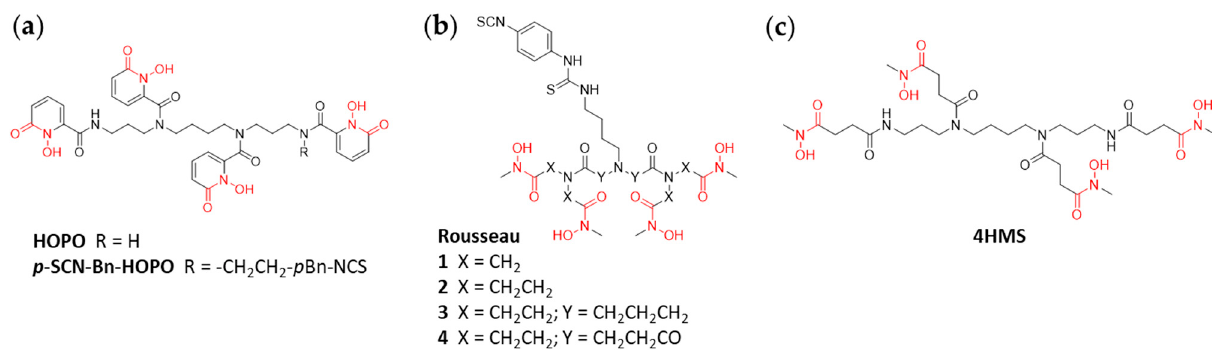
Figure 6. Acyclic hydroxamate chelators. ( a ) 1,2-hydroxypyridone based chelator. ( b ) symmetrical chelators (Rousseau 1 and 2) based on a 2,2 ′ -iminodiacetamide backbone; Rousseau 3 and 4 based on extended iminodipropionamide and dipropylenetriamine backbones, respectively. ( c ) A spermine backbone-based chelator.